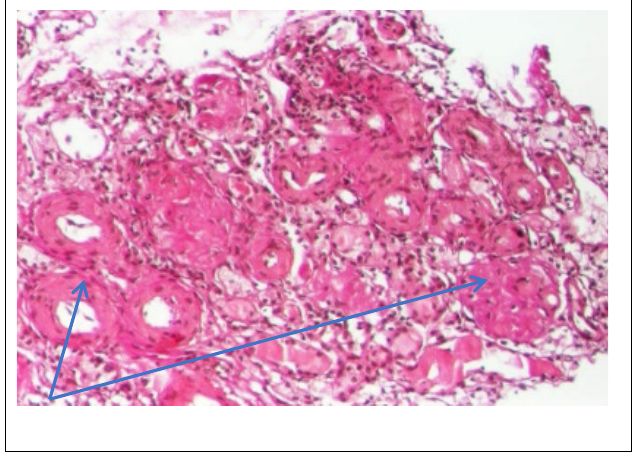
Figure 2. Abdominal CT scan—expansive renal formations replacing renal parenchyma and with a mass effect (blue arrow).